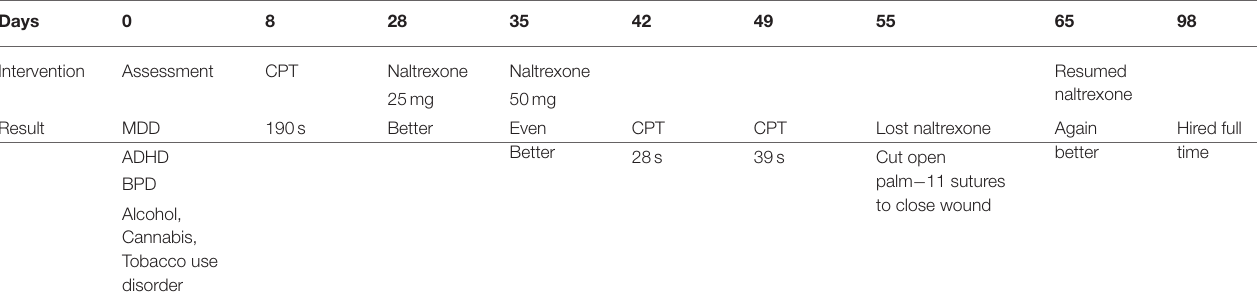
TABLE 1 | Population-adjusted rates of autism and opioid prescribing in the United States *adjustment based on 1991 population. Days 0 8